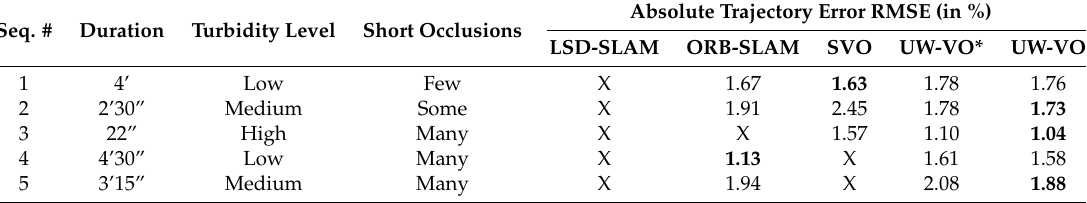
Table 2. Absolute trajectory errors (RMSE in %) for five underwater sequences with different visual degradation. Results are given averaging over five runs for each algorithm. UW-VO* designates our method without the retracking step, while UW-VO designates our method with the retracking step. Seq. #